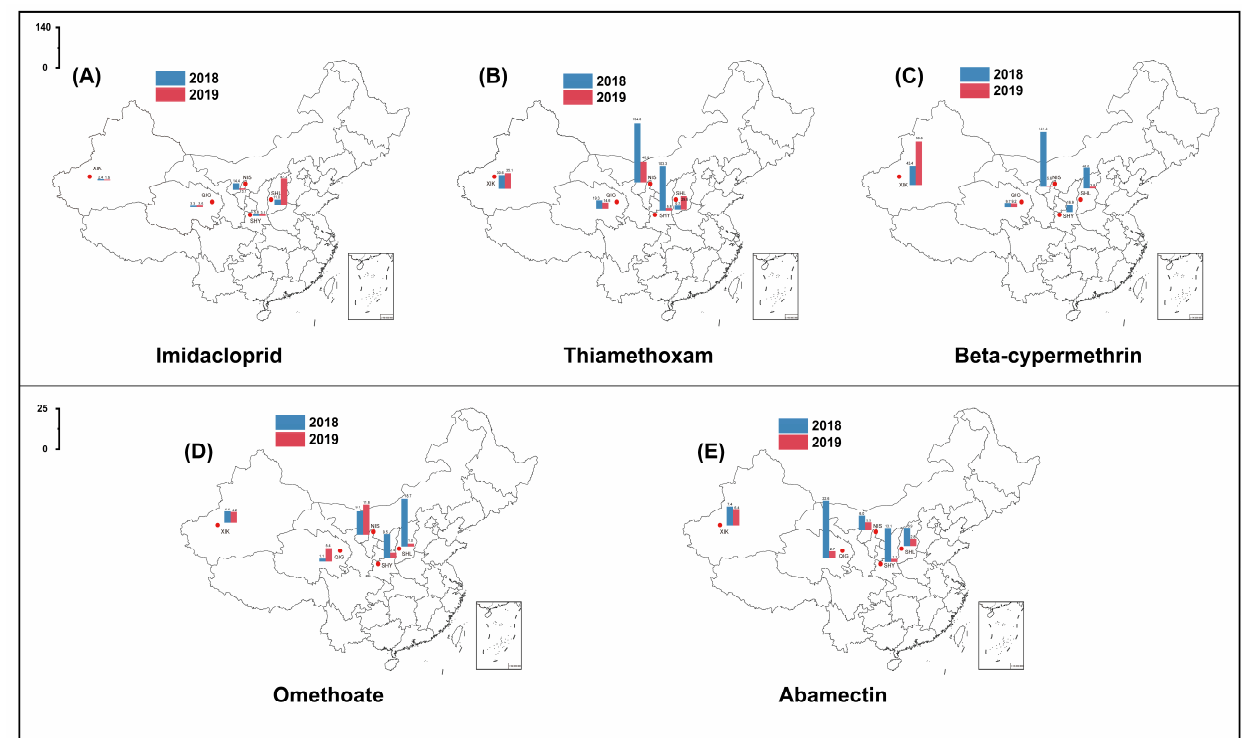
Figure 3. Insecticide susceptibility of Metopolophium dirhodum collected at the same sites in 2018 and 2019, ( A ) Imidacloprid; ( B ) Thiamethoxam; ( C ) Beta-cypermethrin; ( D ) Omethoate; ( E ) Abamectin. Blue and red bars represent the resistance ratios in 2018 and 2019, respectively.